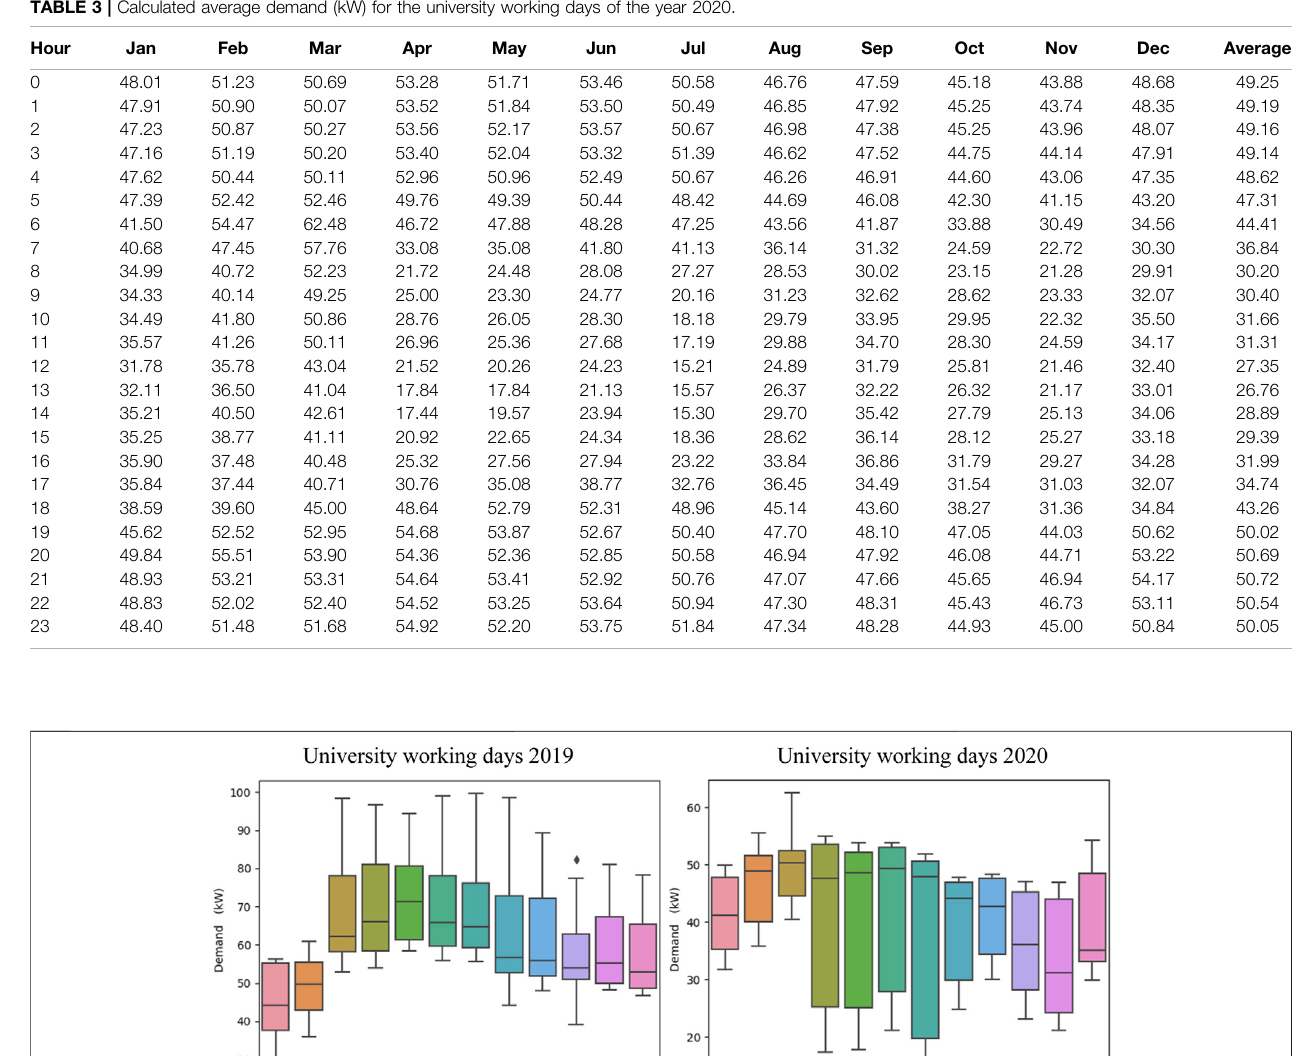
Frontiers in Energy Research |